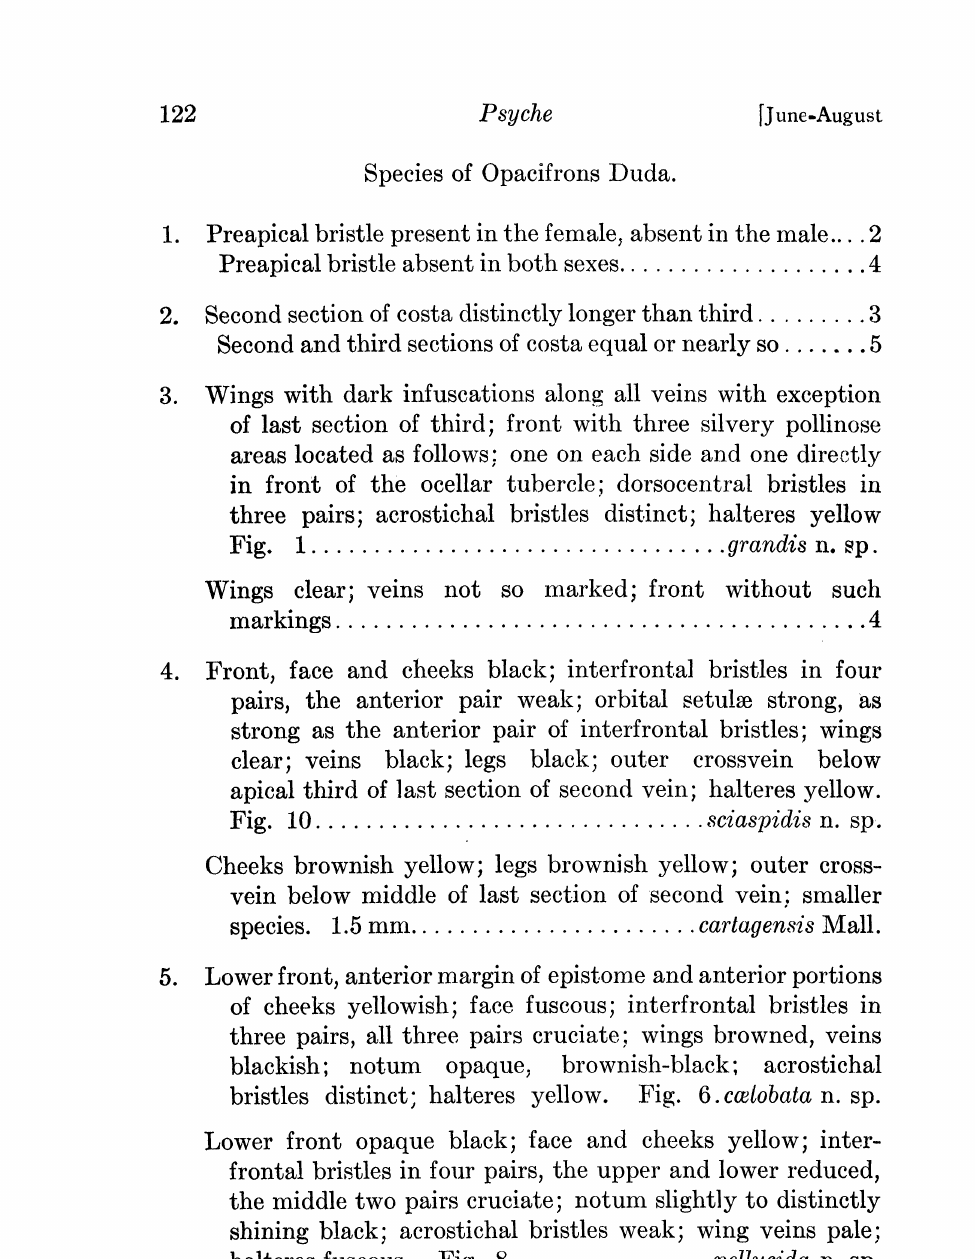
Fig. 8 pellucida no